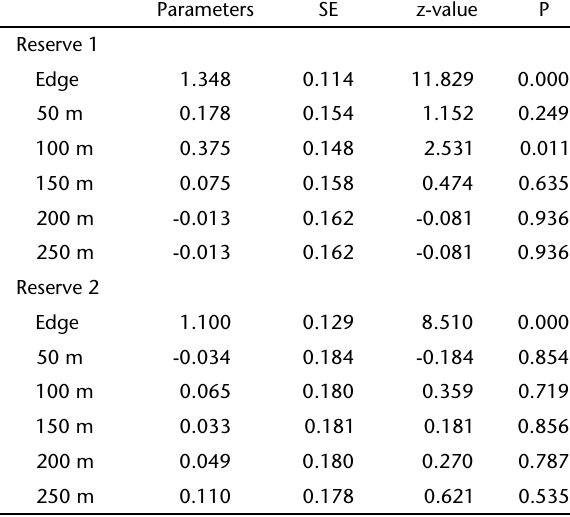
Table II. Model parameters (intercepts) for edge effects on ant ground-dwelling ant species richness at baits in two Cerrado legal reserves, as estimated from a generalized linear model, using Poisson errors (SE = standard error; parameter estimates given are on the log scale; note that positive/negative parameter estimates indicate positive/negative effects relative to the edge intercept, which represents average ant species richness at